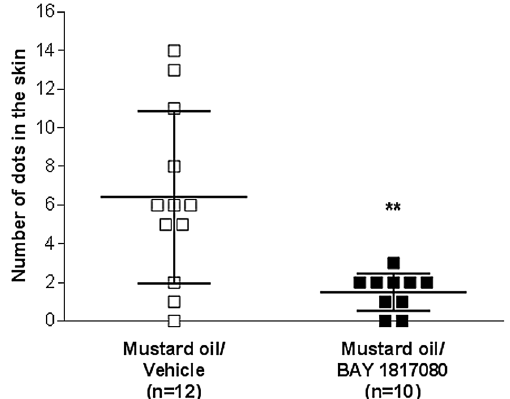
Figure 3. Eliapixant (BAY 1817080) shows efficacy in a rat model of uterine neurogenic inflammation. Female Sprague Dawley rats in pro-estrus phase were treated with either a bolus intravenous injection of eliapixant (0.7 mg/kg), which was followed by an intravenous infusion of 0.2 mg/kg eliapixant or the vehicle (saline) (n = 10 or 12, respectively). Inflammation of the uterus (induced by mustard oil) in rats results in blue dye extravasation (or blue dots) on the ventral and dorsal side of the abdominal region. The individual number of dots in the skin and the mean ± standard deviation for each group is shown; ** P < 0.01 versus the mustard oil/ vehicle group, Mann–Whitney U